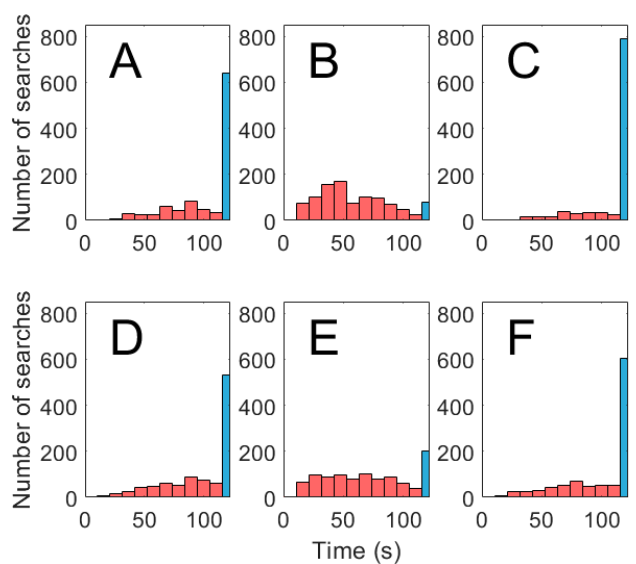
Figure 8. Total time spent searching until source located using ( A ) concentration measured along the antennule, ( B ) concentration measured along the antennule combined with leg chemosensing, and ( C ) concentration combined with transverse flow mechanosensing measured along the antennule. Total time spent searching until source located using ( D ) intermittency measured along the lobster antennule, ( E ) intermittency measured along the antennule combined with leg chemosensing, and ( F ) intermittency measured along the antennule combined with transverse flow mechanosensing. Searches that lasted 120 s were unsuccessful and shaded blue.